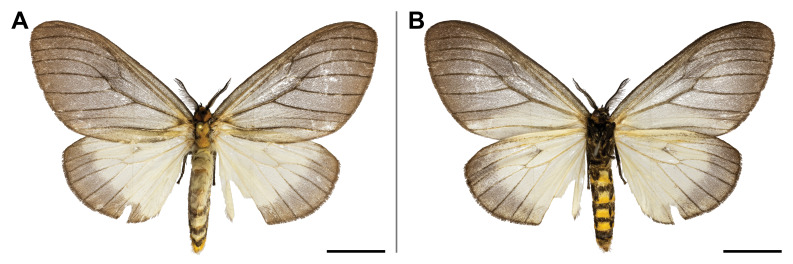
Pirga
ubangiana Schultze, 1934. A. dorsal view; B. ventral view. The scale bar represents 1 cm.